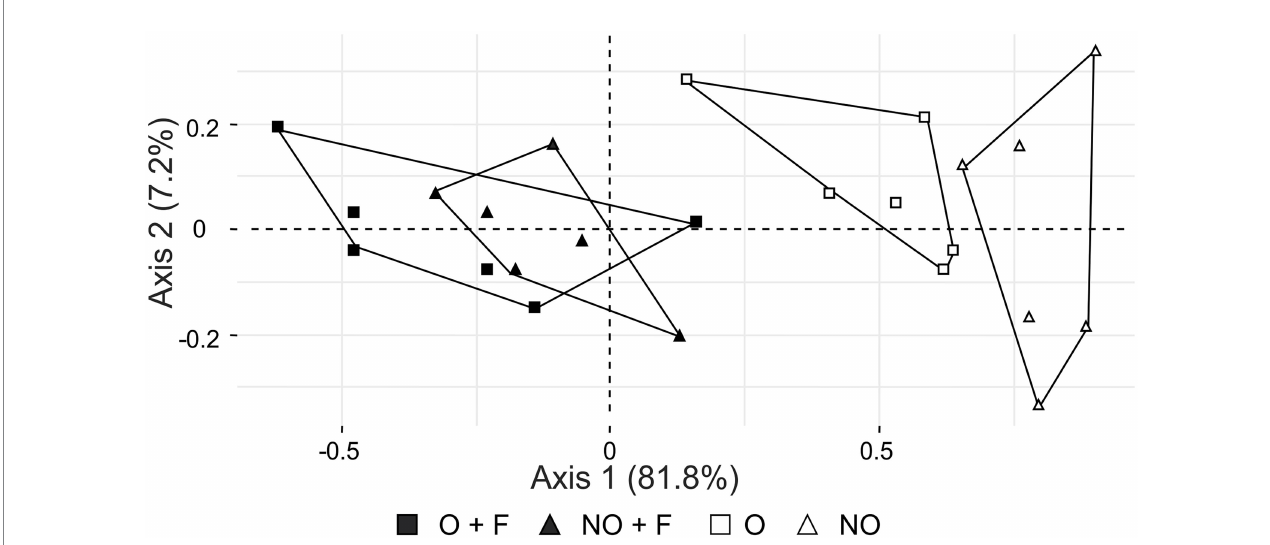
FIGURE 6 Correspondence analysis showing the effects of N. oligospilus oviposition and feeding on the volatile emission profiles of willows. Ellipses represents a plot of the convex hull of the samples of each treatment: ( △ NO) no oviposition-no feeding, ( □ O) oviposition-no feeding, ( ▲ NO + F) no oviposition-feeding and ( ■ O + F) oviposition-feeding. Oviposition always preceded feeding. Percentage of explained inertia is expressed in